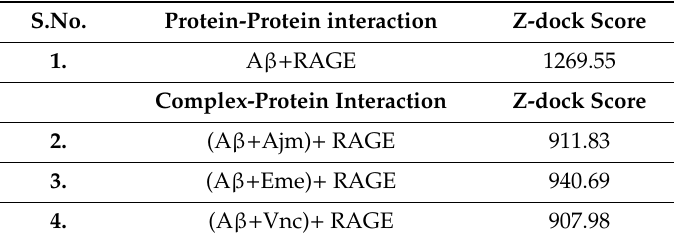
Table 4. Score of protein-protein and complex-protein interactions.